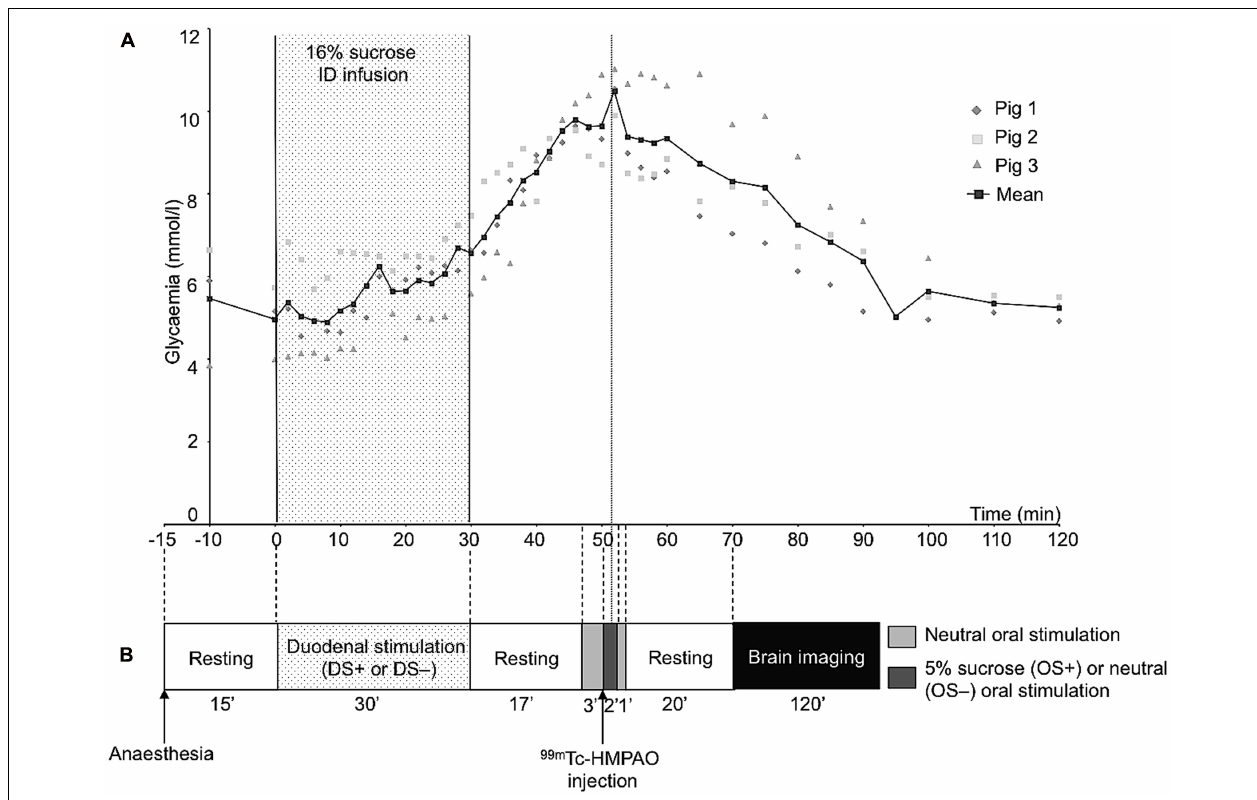
99m Tc has a fast fixation time, the initial tracer uptake reflects cerebral blood flow (CBF) at a fast time window after injection (Kapucu etal., 2009). Consequently, the CBF recorded during imaging, that is 20 min after the radiolabel injection, corresponded to the CBF measured at the time of the radiolabel injection, that is during the oral sensing of artificial saliva added with 5% sucrose (OS + ) or unsweetened artificial saliva (OS–, control), and during the peak of maximal glycaemia resulting from the ID infusion of 16% sucrose (DS + ) or after ID infusion of saline (DS–,